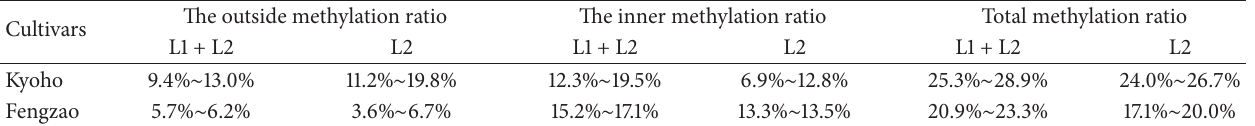
Table 5: Analysis of methylation levels in grapes L2 with 14 MSAP primer combinations.